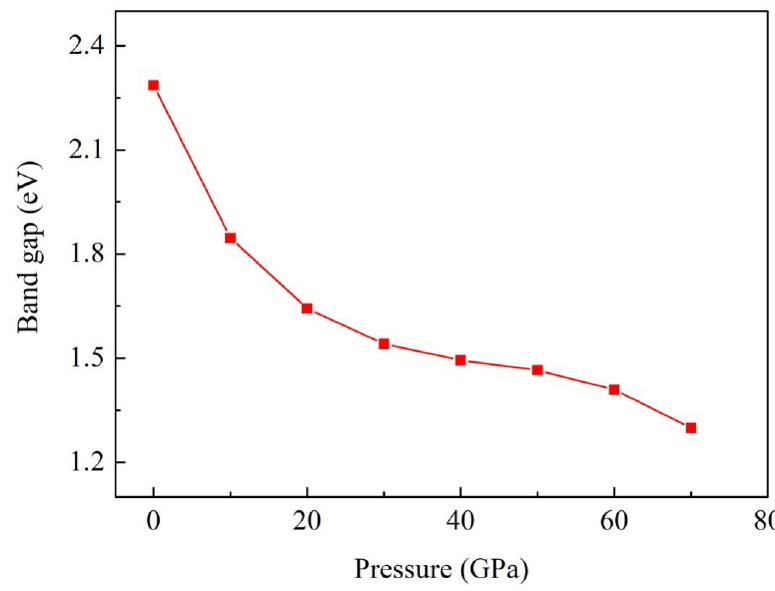
Figure 7. The bandgap of DNTF under different